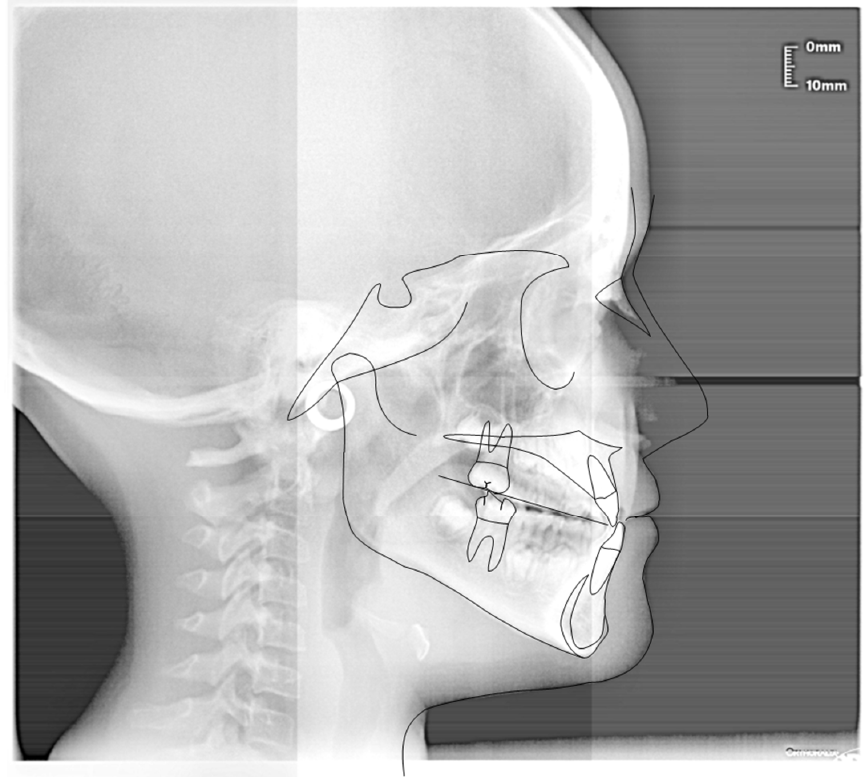
Figure 15. Cephalometric tracing (DeltaDent software) before treatment reveals a skeletal class III malocclusion (7-year-old).